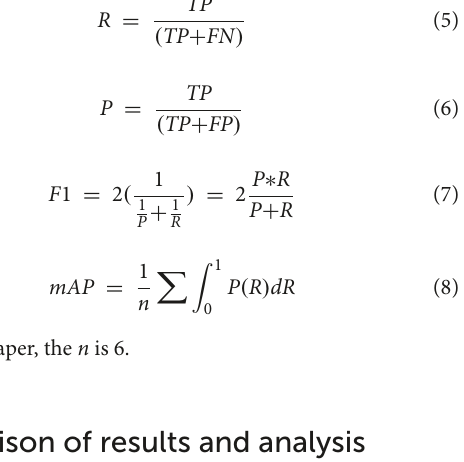
(7) is the formula for the F1 score. The mAP is calculated using the equation from VOC2010 onward as shown in Equation